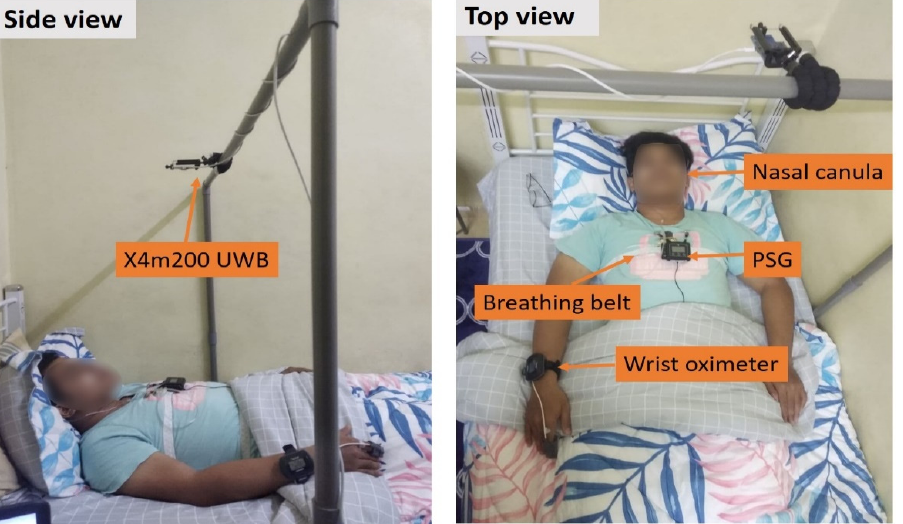
Figure 1. Experimental design for data collection.